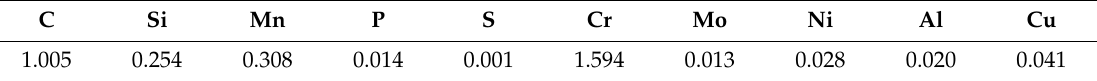
Table 1. Chemical compositions of the GCr15 bearing steel (wt. %).